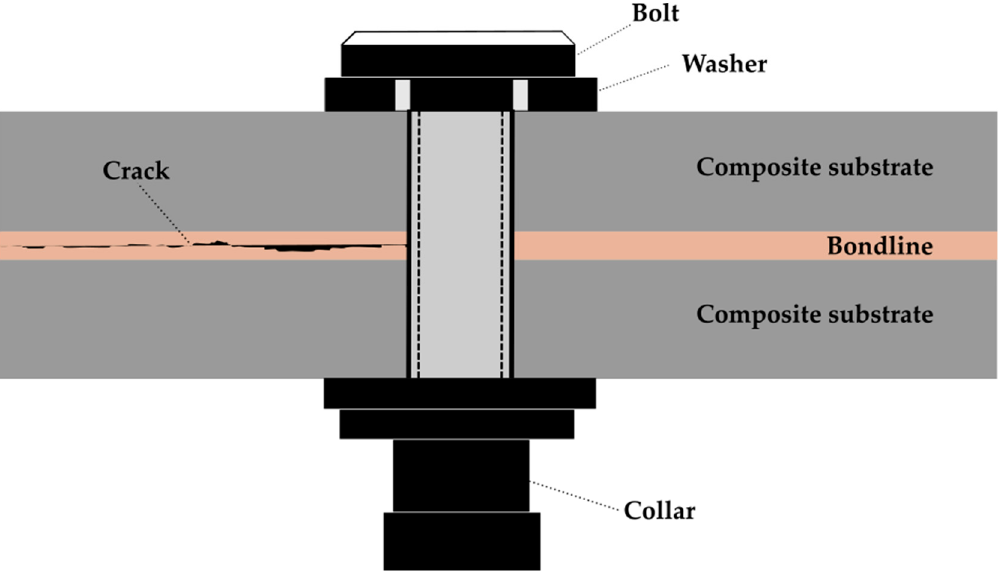
Figure 9. Lockbolt installed in the bonded substrates.